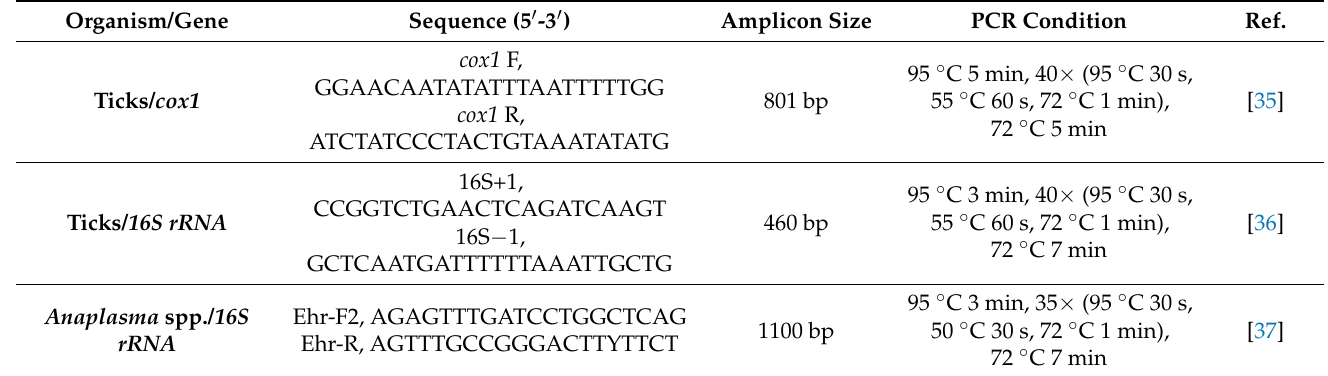
Table 1. Primers used for the detection of ticks and associated Anaplasma spp.